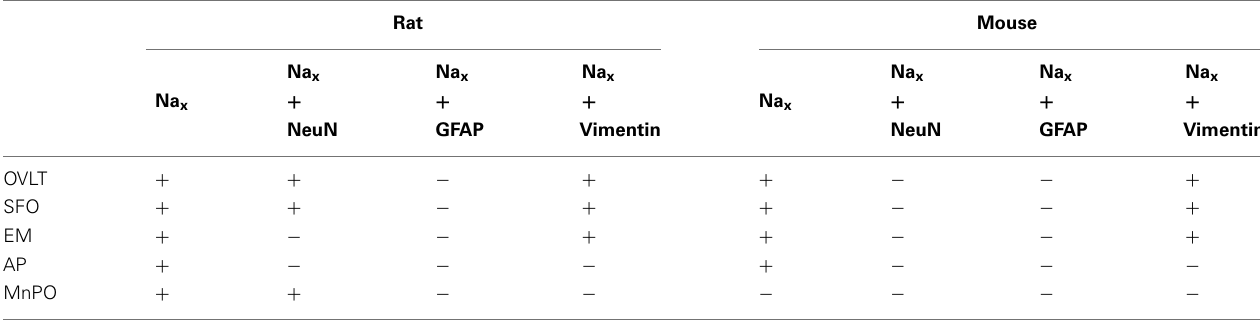
Table 3 | Colocalization of Na x immunostaining with fluorescent cell markers in the CVOs and the